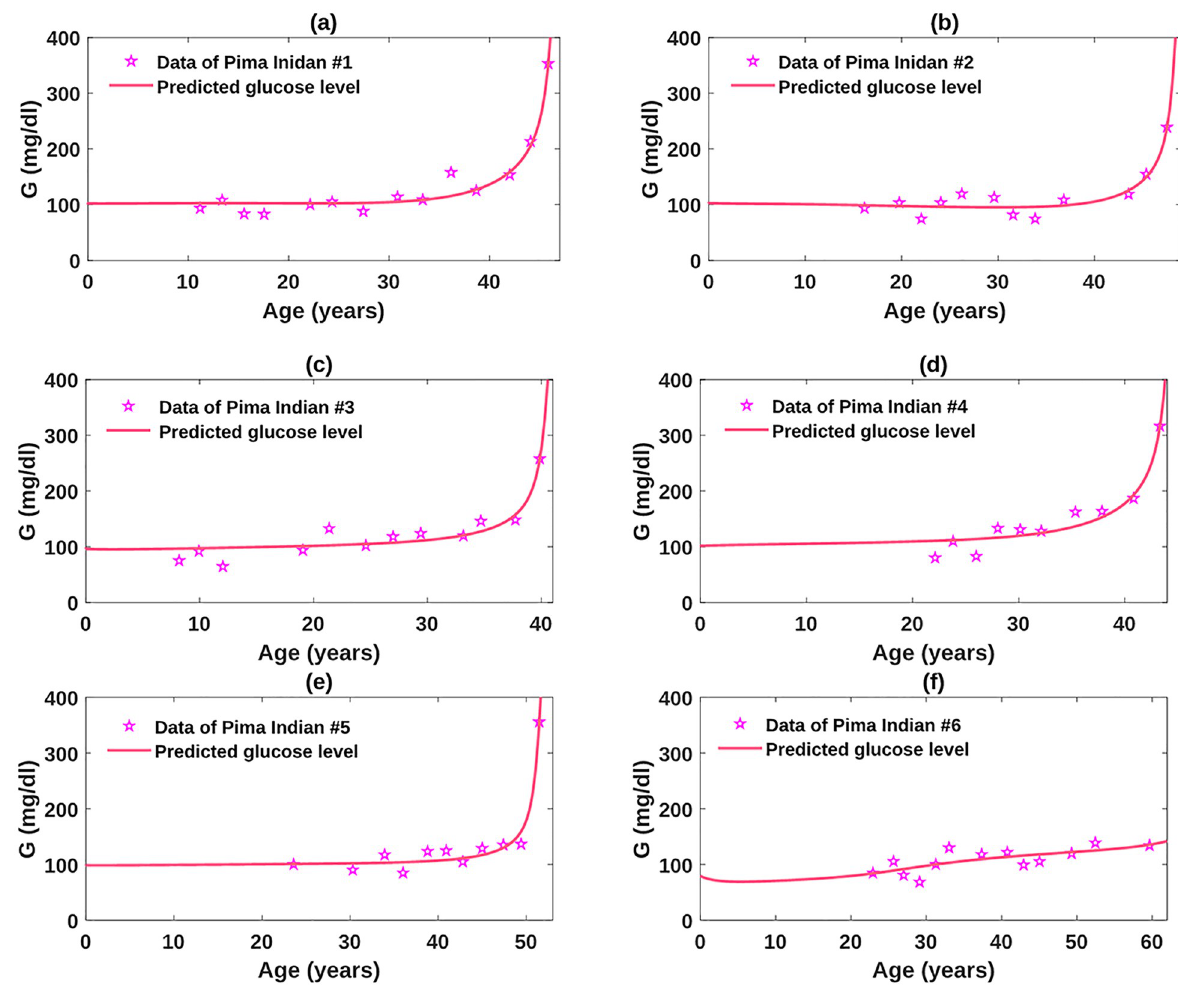
Fig 8. Obesity-related diabetes model fit to plasma glucose data for Pima Indian #1–#6. Overall, the glucose levels of these patients were steadily trending upwards.